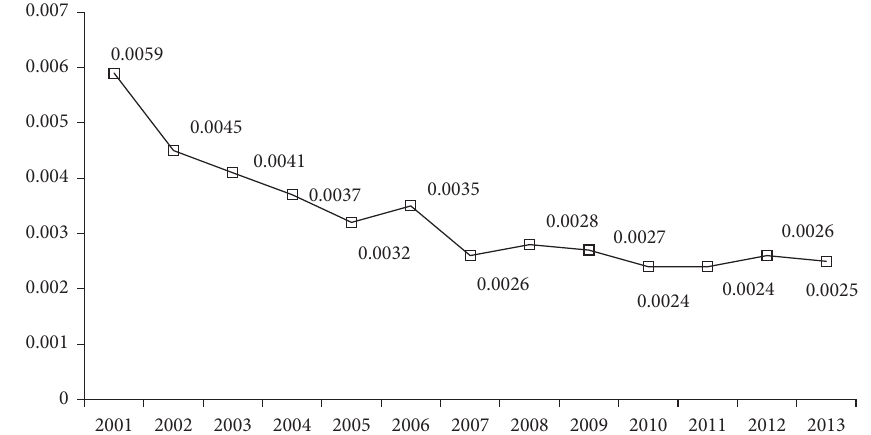
Figure 3: Evolution of average distance of international talent migration network from 2001 to